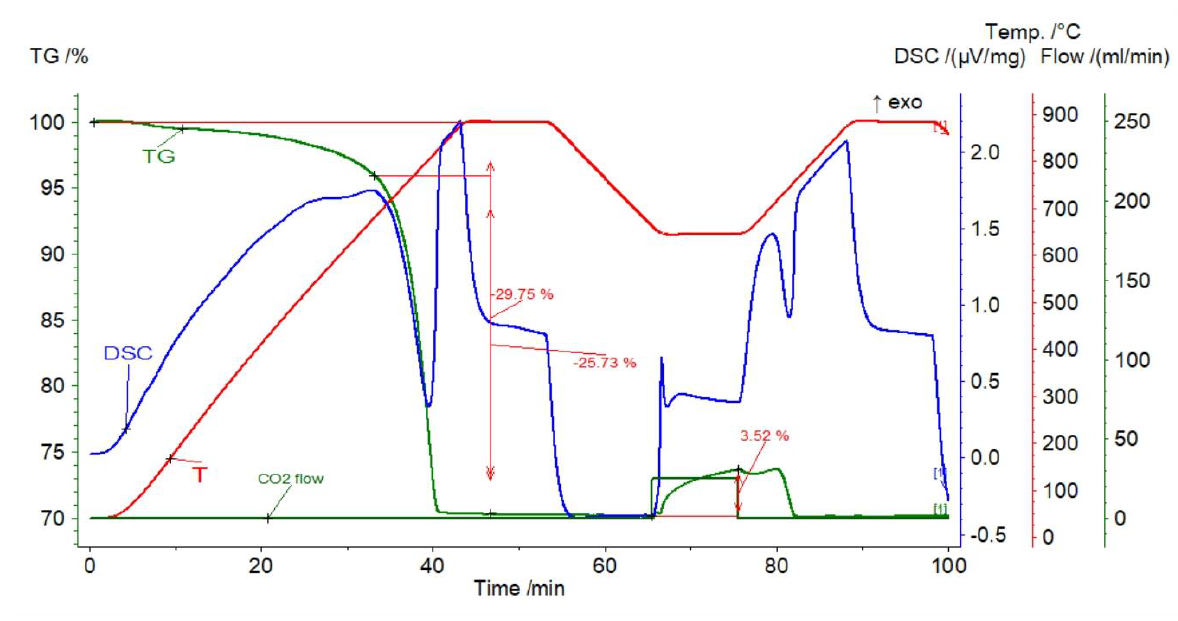
Figure 8. TGA and DSC curves for marl.